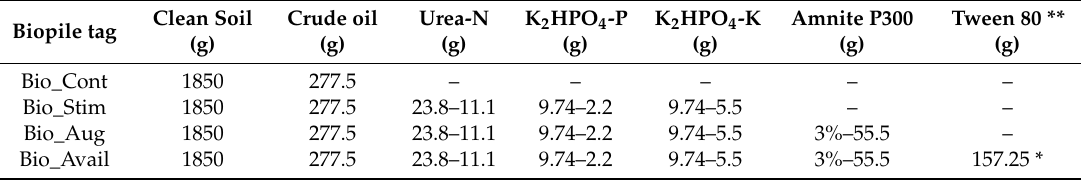
Table 1. Biopile systems